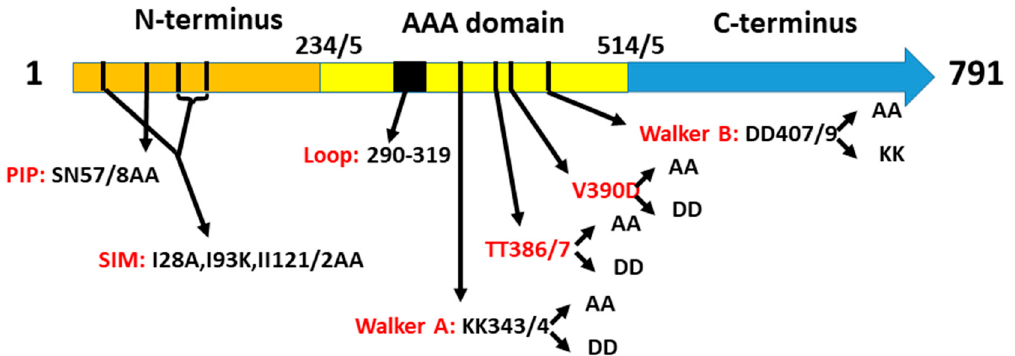
Figure 1. Schematic representation of the Elg1 protein showing domains and mutation sites. The ELG1 gene was divided into three domains. Mutations described in the text affect the N-ter and AAA domains. All proteins are expressed at similar levels.